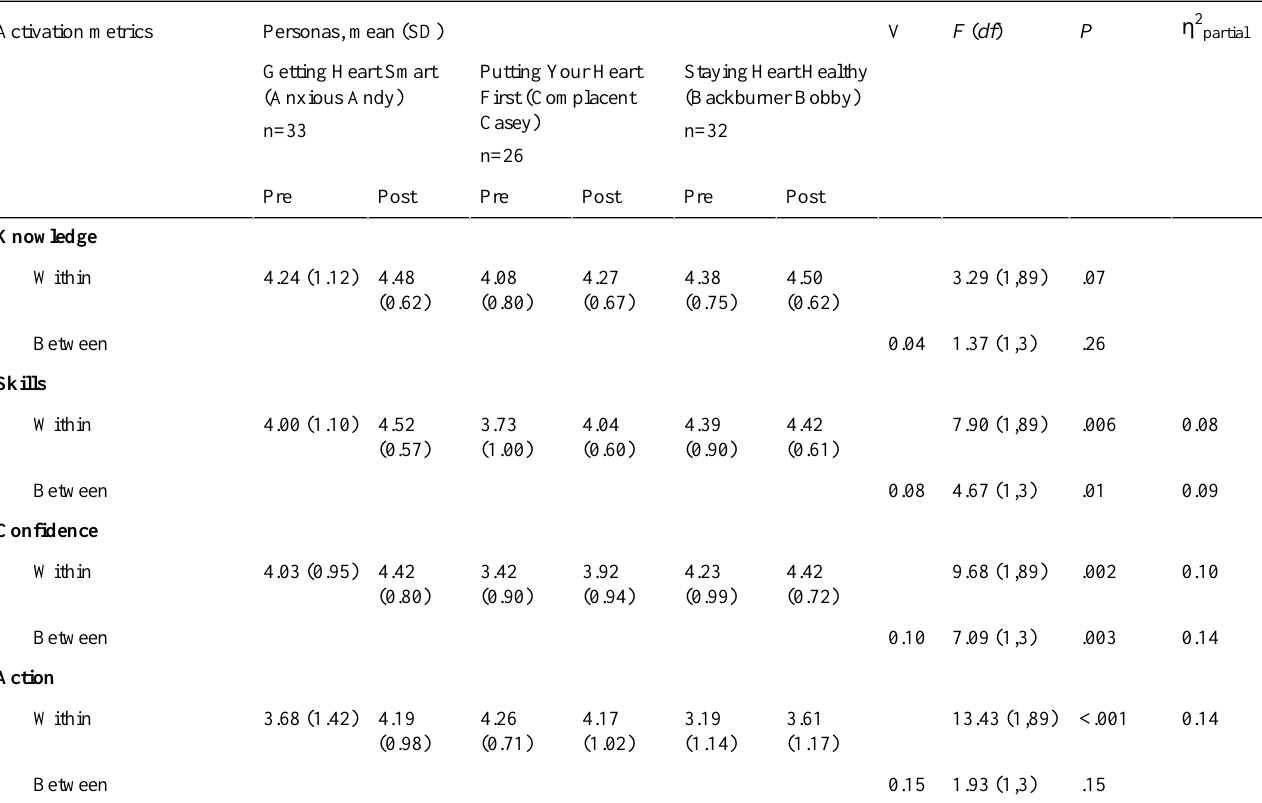
Table 4. Results of general linear model with repeated measures analyses of chronic health disease personas: coronary artery